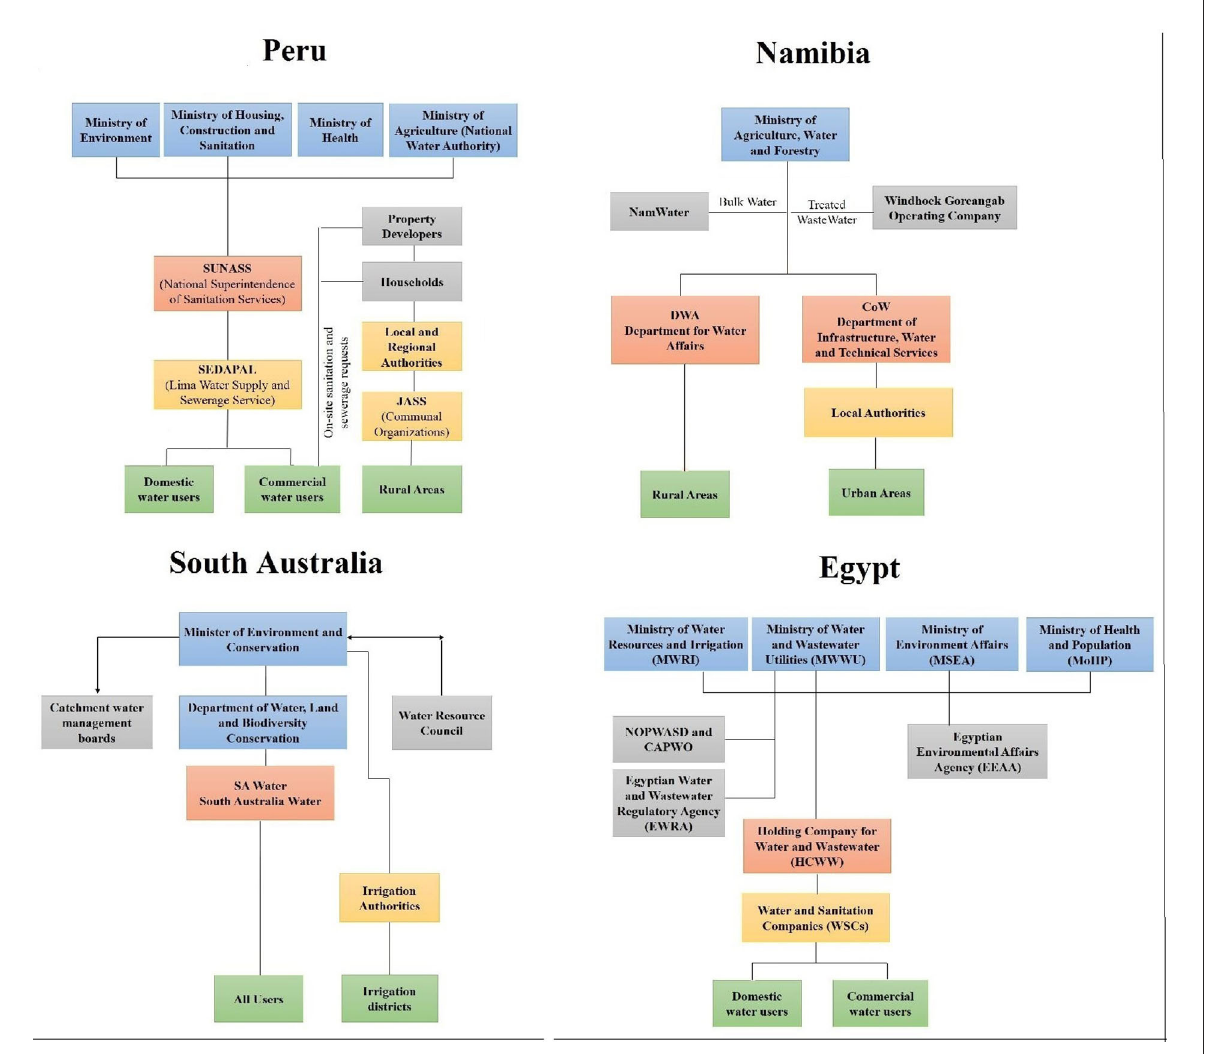
FIGURE4 Comparison of the water service providers in the three case studies and Egypt. The key actors include governmental, regional, and local actors, in addition to standalone organizations and end-users. A hierarchical approach in water management in all studied cases, with some differences in rural and urban water management. In the figure, organizations that are perceived at the same administrative and influence level for water management are assigned with similar colors (based on Australian Government, 2003; Harding, 2012; Ioris, 2012; Furlong, 2016; Mumssen and Triche, 2017; Nghipangwa, 2017; Scott et al.,